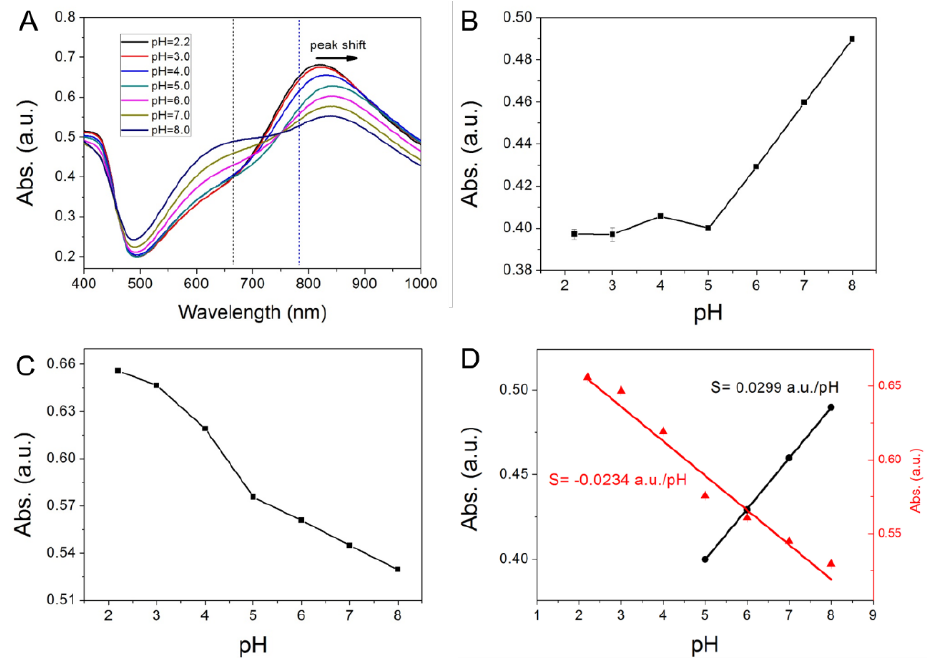
Figure 5. ( A ) Visible-NIR spectra of PANI-GNPs-glass in pH = 2.2, 3.0, 4.0, 5.0, 6.0, 7.0, 8.0 media; ( B ) The changes of absorbance at 665 nm in different pH media; ( C ) The changes of absorbance at 785 nm in different pH media; ( D ) Two pH linear ranges of this PANI-GNPs-glass biosensor based on absorbance at 665 nm (black) and absorbance at 785 nm (red).